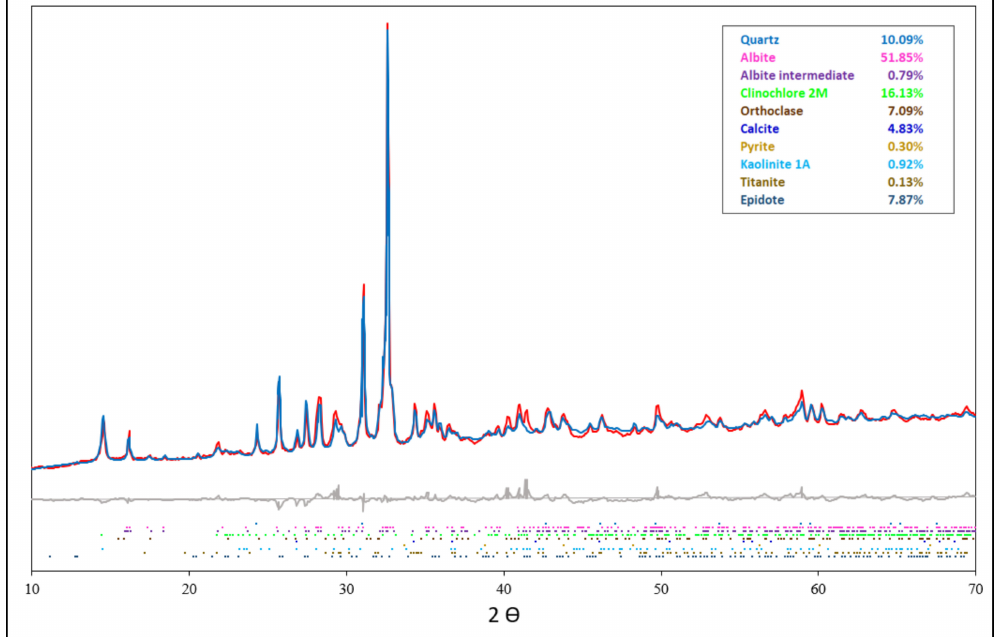
Figure 2. XRD pattern of unreacted copper flotation